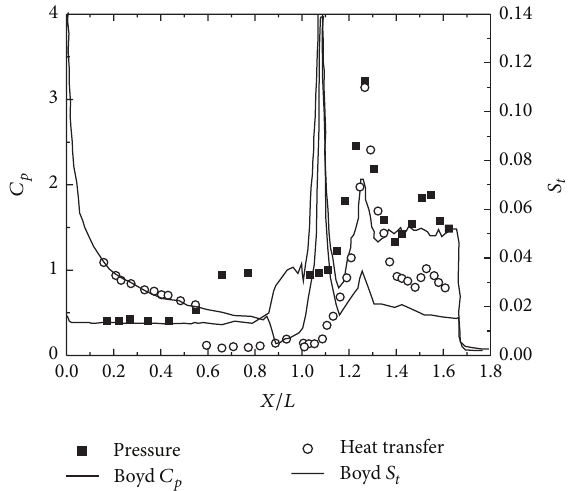
Figure 10: Boyd’s DSMC for Run number 28 [15].